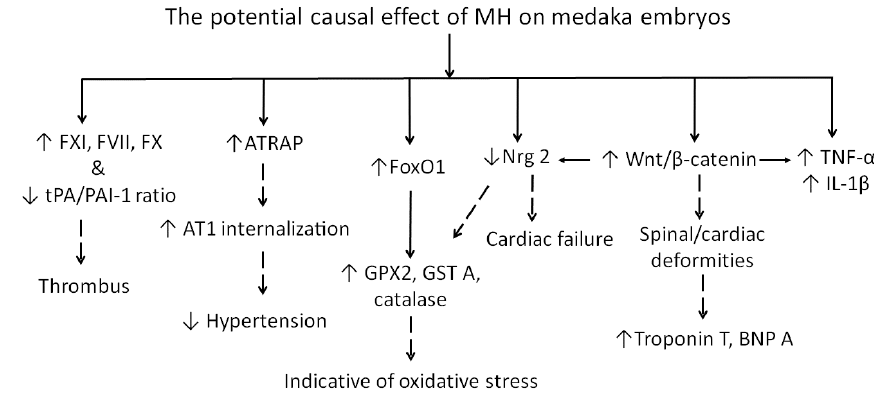
Figure 11. Flowchart depicting MH treatment induces cellular and morphological changes in medaka embryos that lead to inflammation, thrombosis, spinal, and cardiac deformities. Solid arrows indicate the direction of the effects of MH on indicators of increased inflammation/cardiovascular risk and the anatomic locations as well as a link with the prior object/event. The flow of physiological changes that require further investigations are shown in dashed arrows. Legend: ATRAP, angiotensin receptor-associated protein; AT1, angiotensin type I receptor; β -catenin, beta catenin; BNPA, brain natriuretic peptide type A; FVII, Factor VII; FX, Factor X; FXI, Factor XI; FoxO1, Forkhead box O1; GPX2, glutathione peroxidase 2; GST A, glutathione S-transferase A; IL-1 β , interleukin-1 beta; Nrg 2, neuregulin 2; tPA, urokinase plasminogen activator; PAI-1, plasminogen activator inhibitor 1; Wnt, wingless/integrated oncogenes.